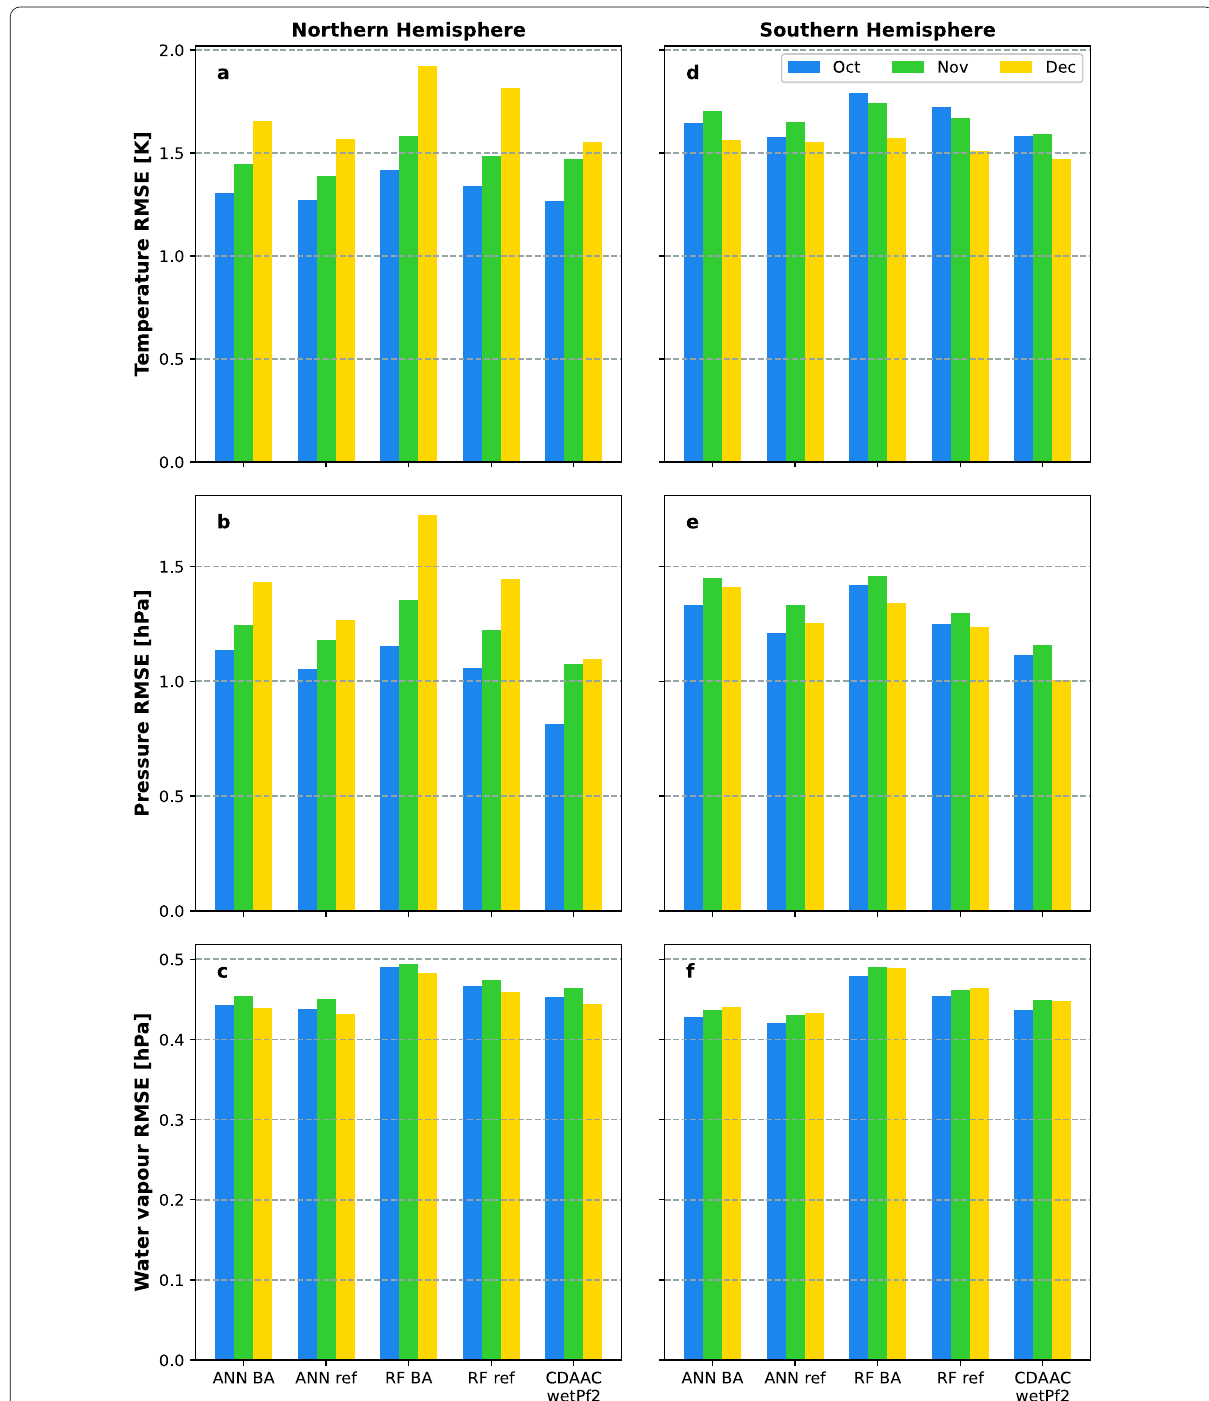
Fig. 5 Fitting results for different months on the Northern (left panels) and Southern (right panels) hemispheres. The bars show vertically averaged RMSE for temperature ( a , d ), pressure ( b , e ), and water vapor partial pressure ( c , f ) computed between ERA5 and different ML models or CDAAC wetPf2 product on test data sets. Blue, green, and yellow distinguish events in October, November and